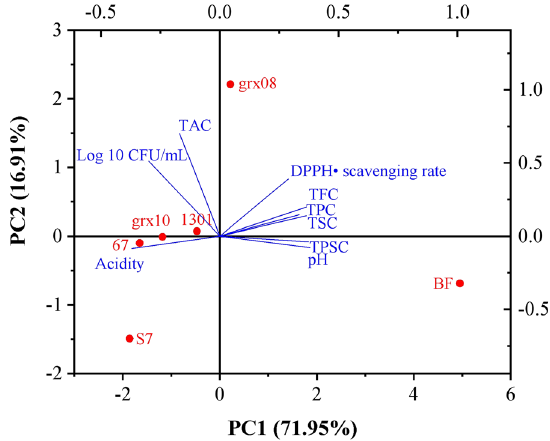
Fig. 6 Principal component analysis of fermentation growth, fermentation characteristics and antioxidant properties of different